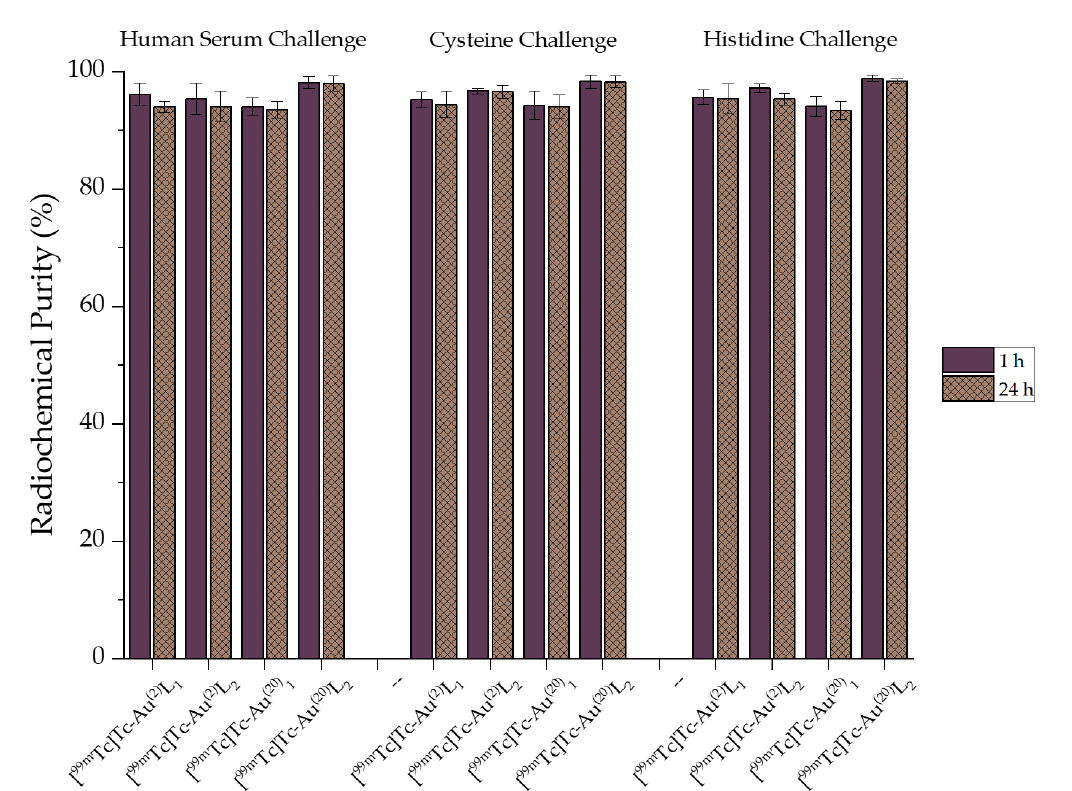
Figure 9. In vitro stability of [ 99m Tc]Tc-Au (2) L1, [ 99m Tc]Tc-Au (2) L2, [ 99m Tc]Tc-Au (20) L1, and [ 99m Tc]Tc-Au (20) L2 at 1 h and 24 h post-radiolabeling. Table 2. Partition Coefficient of [ 99m Tc]Tc-Au (2) L1, [ 99m Tc]Tc-Au (2) L2, [ 99m Tc]Tc-Au (20) L1 and [ 99m Tc]Tc-Au (20) L2.